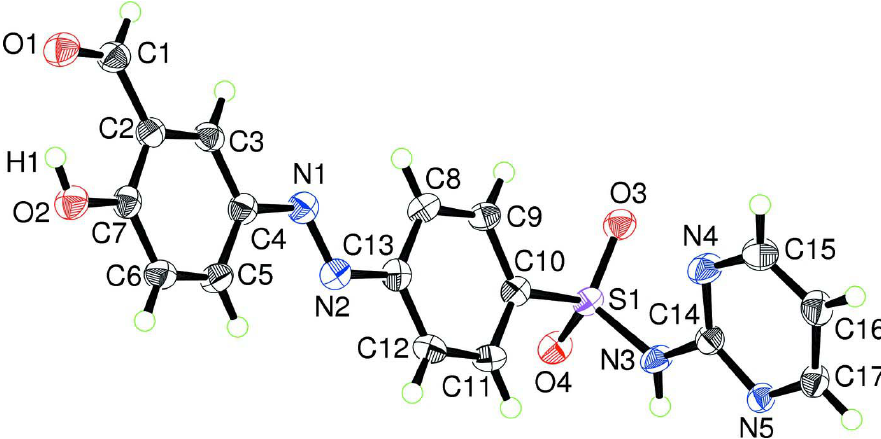
The molecular structure of (I) showing the atom-labeling scheme. Displacement ellipsoids are drawn at the 50% probability